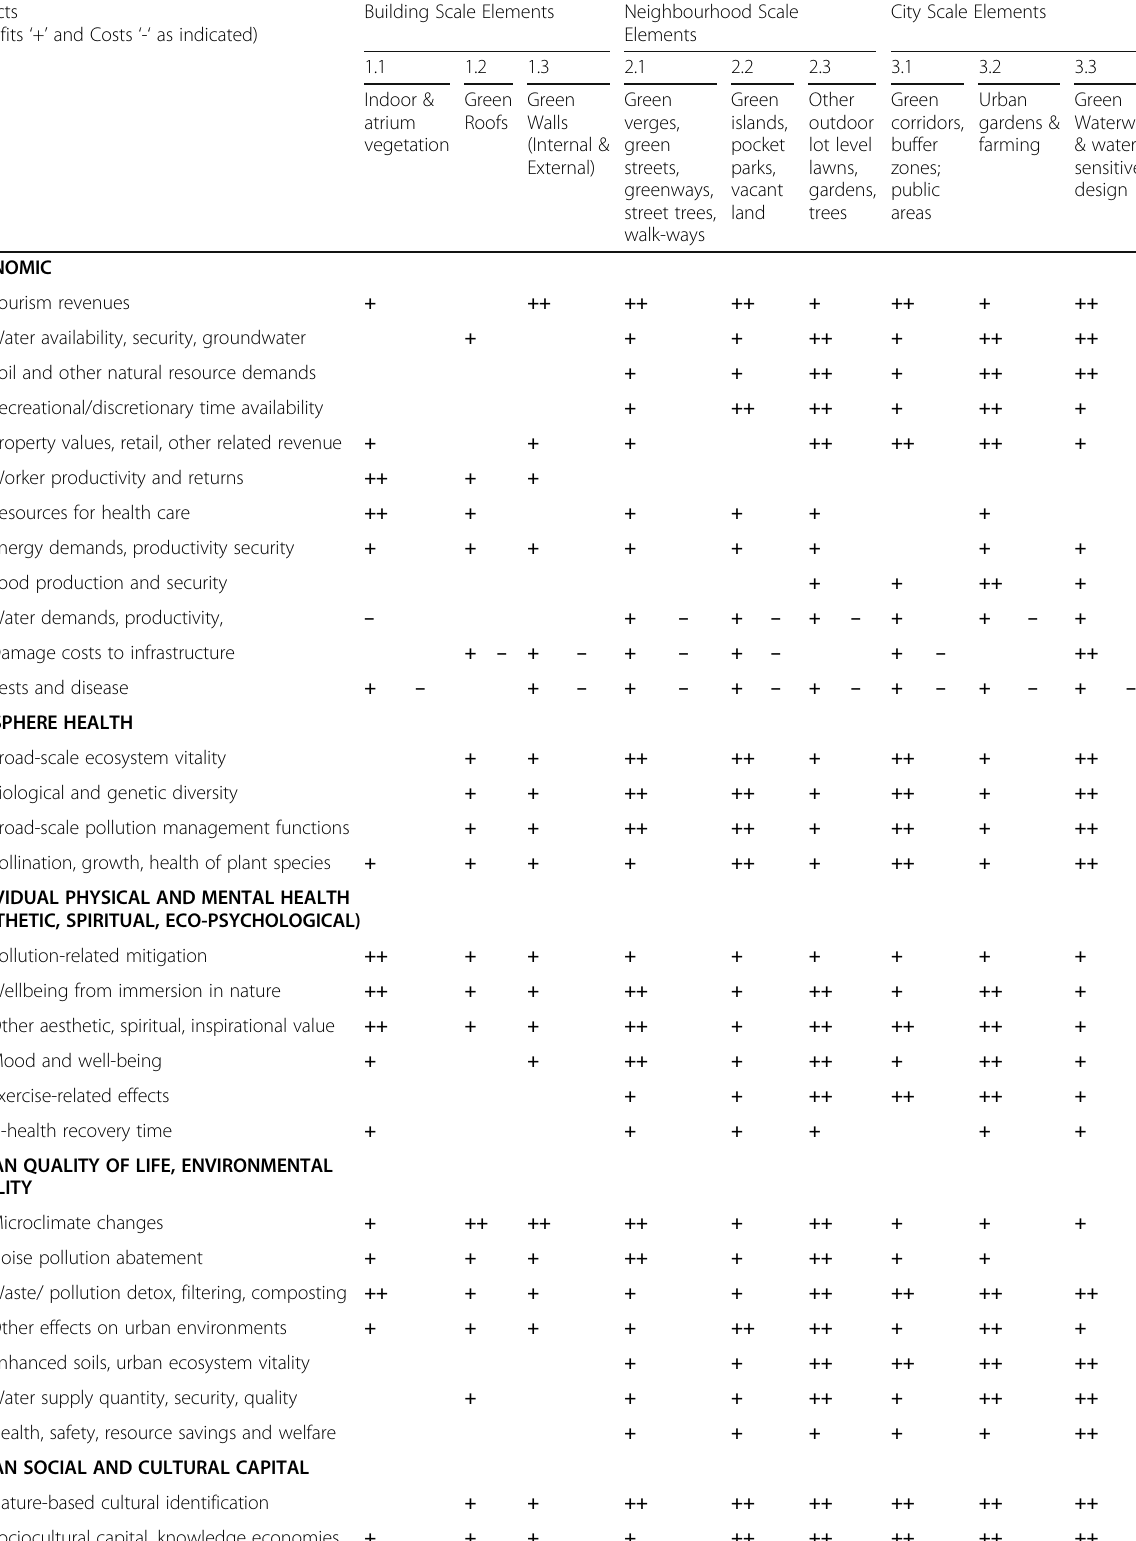
Table 2 The community benefits and costs of urban greening (with a focus upon biophilic urbanism elements) Impacts (Benefits ‘ + ’ and Costs ‘ - ‘ as